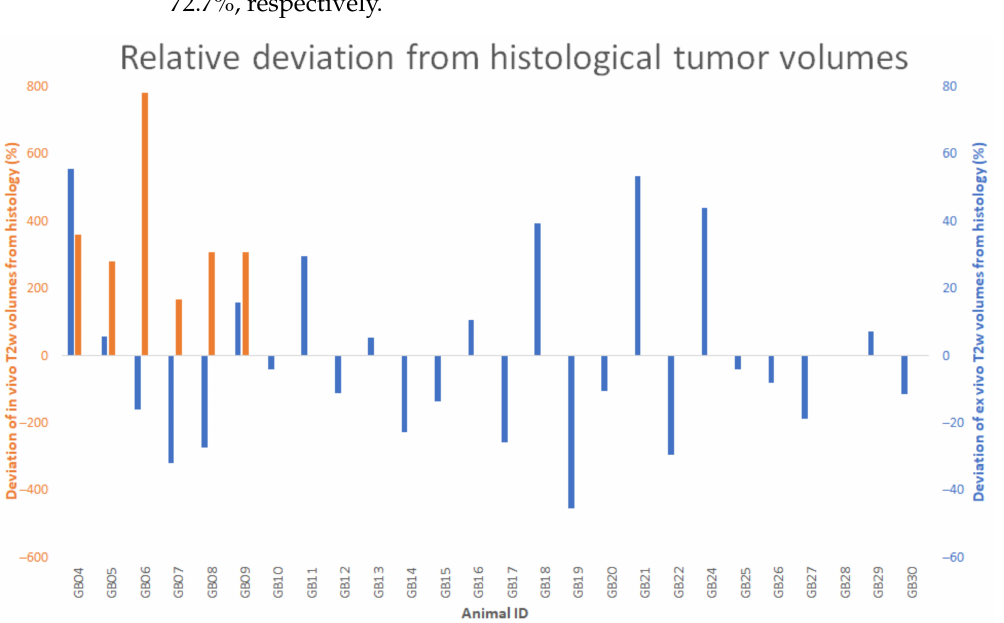
Figure 2. Plot of volume deviations on in vivo and ex vivo T2w images compared to histology. In this plot, the relative deviation of volumes of the estimated abnormal mass on in vivo and ex vivo T2w images compared to histological tumor volumes is shown, with a mean relative deviation of 368.2% and 21.0%, respectively. Note the difference in the range of the axes. This figure illustrates that there is no trend in the difference between volumes of the estimated abnormal mass on ex vivo T2w images and histological tumor volumes, whereas the volumes of the estimated abnormal mass on in vivo T2w images tend to be much bigger than the histological tumor volumes.